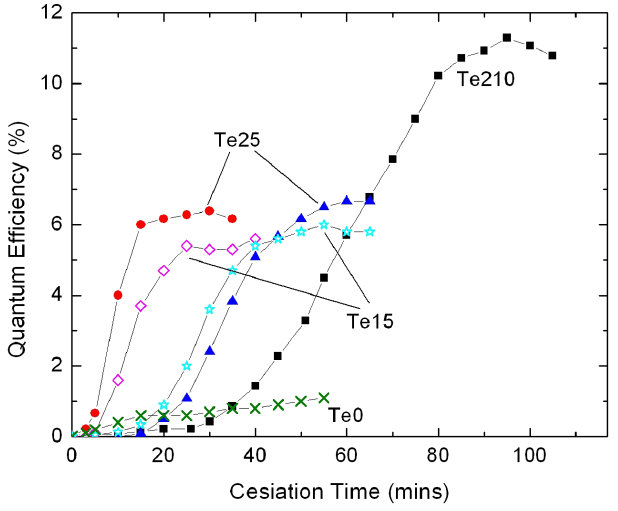
FIG. 1. QE evolution of Cs 2 Te photocathode on Nb substrate during Cs deposition. Te210 means the cesiation was performed after 210 Å Te film was deposited, while Te25 and Te15 were done on 25 and 15 Å, respectively. Te0 is a cesiated Nb surface with no Te